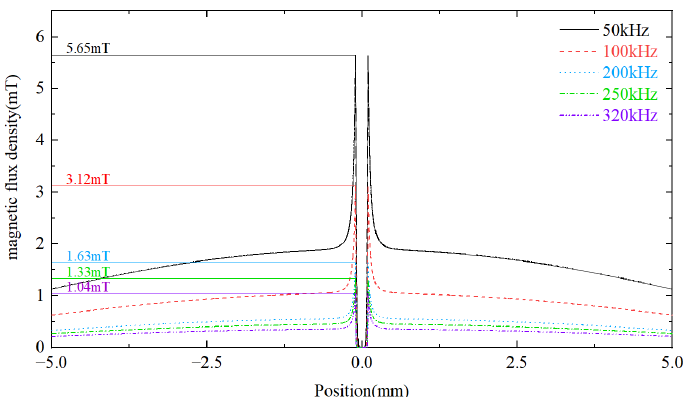
Figure 4. Distribution of the magnetic flux density along z-axis under the excitation of different frequencies.